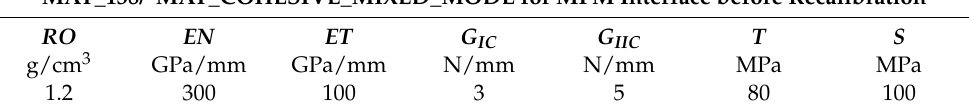
Table 3. Material card parameters for the cohesive elements representing the MPM interface before recalibration.